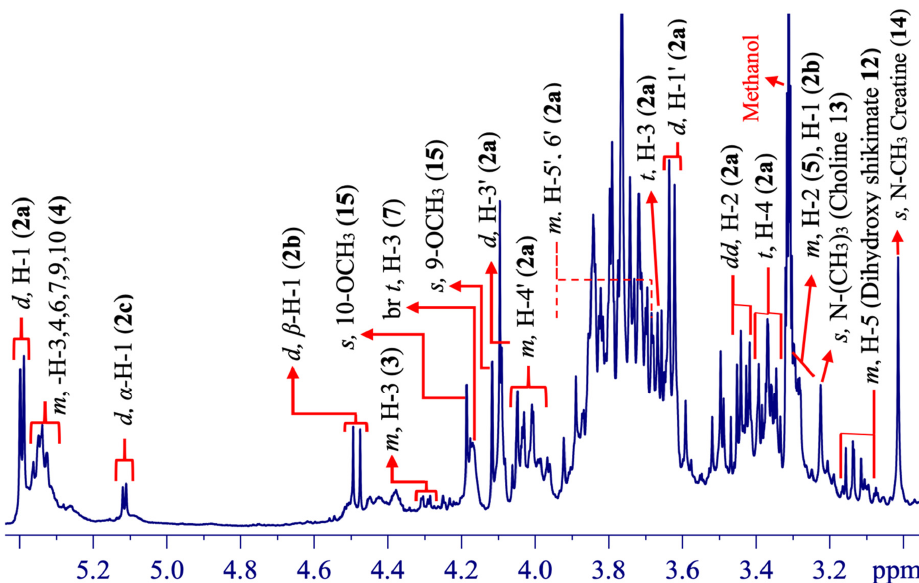
Figure 5. 1 H HR-MAS NMR ( ẟ 2.90–5.45) spectrum showing signal annotations from the leaves of Berberis laurina (400 MHz, ~10 mg swollen in 40-µL CD 3 OD).